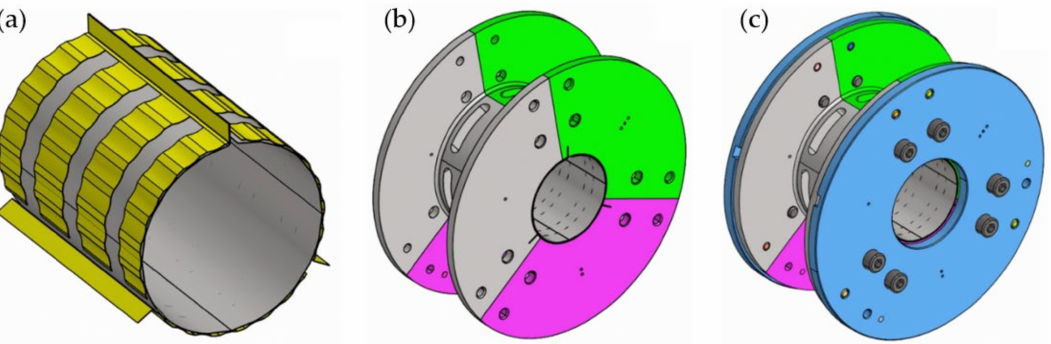
Figure 3. CAD model of the developed prototype a GFB: ( a ) top foil (seen as the inner grey cylindrical component) covered by the set of three bump foils (marked in yellow), ( b ) spool-shaped bushing composed of joined tierces (visualized with three different colors), ( c ) complete assembly equipped with two side flanges (marked in